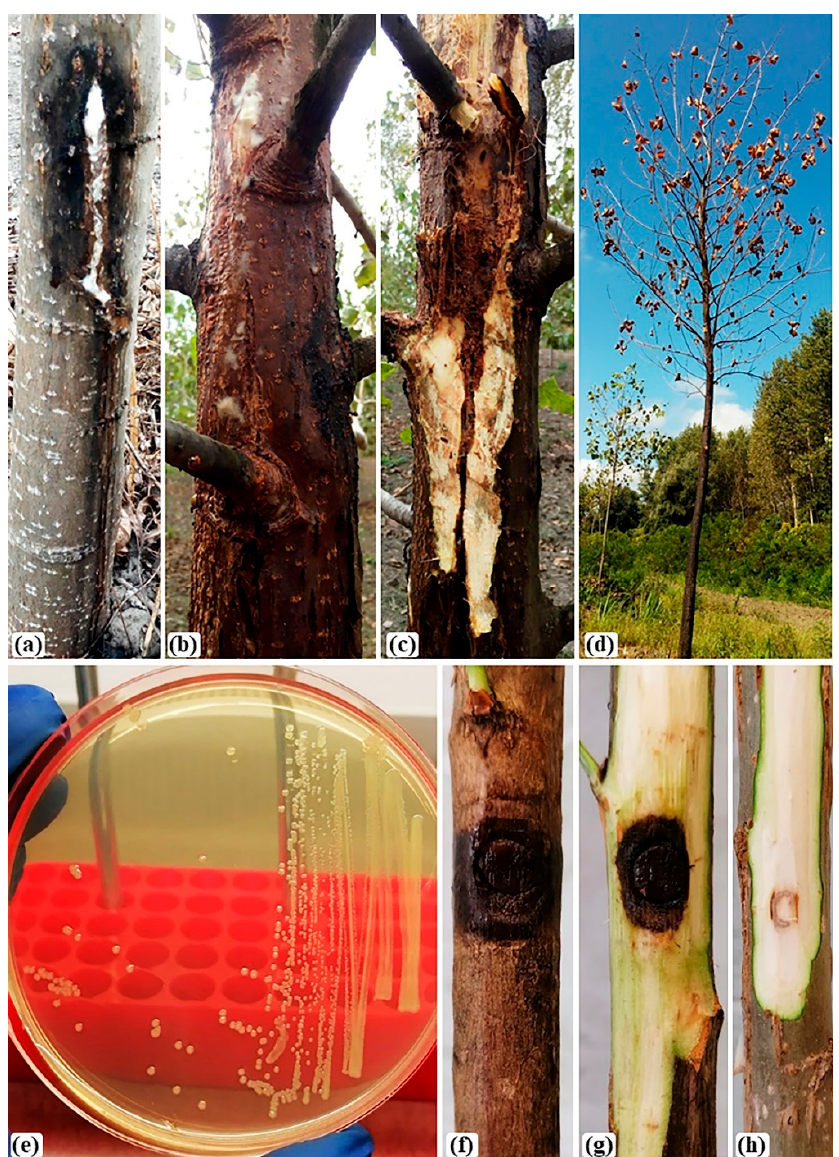
Figure 1. Bacterial canker disease on Populus × euramericana clone “I-214” caused by Lonsdalea populi in Serbia. ( a ) Necrotic bark with foamy sap flowing from the infection site. ( b ) Canker with cracked bark and exudates emerging from the infected stem. ( c ) Softening and darkening of the vascular part of the trunk in the cankered area. ( d ) Dead tree with exudates staining the bark. ( e ) Colonies of L. populi after 24 h of incubation at 30 ◦ C on tryptone soya agar. ( f ) Water-soaked sunken canker formed on P. × euramericana rooted cutting one month after inoculation with L. populi . ( g ) Dark, soft, and watery wood beneath the bark of a canker formed on P. × euramericana rooted cutting one month after inoculation with L. populi . ( h ) Negative control showing absence of canker development.